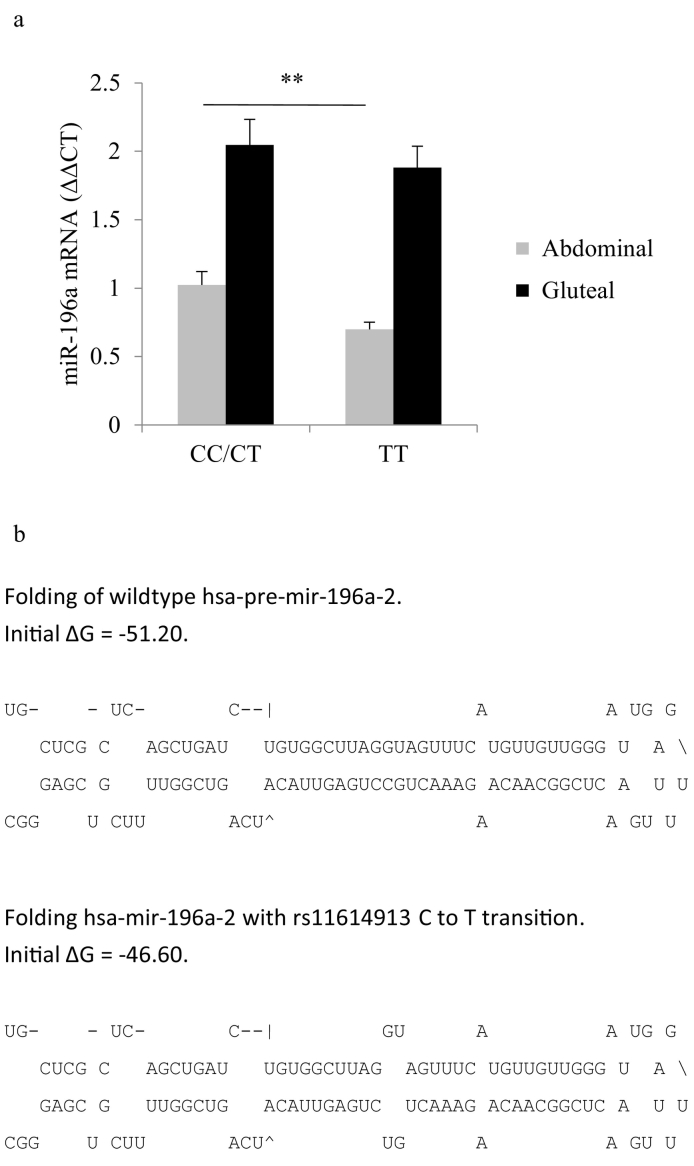
a. miR-196a expression in paired ASAT and GSAT biopsies from age, sex and genotype-balanced group of rs11614913 (n = 30 in each group), **p < 0∙005; t-test.b. Folding and free energy of binding of miR-196a-2 containing the wild-type allele (top) and minor allele (bottom), as predicted in M-fold.